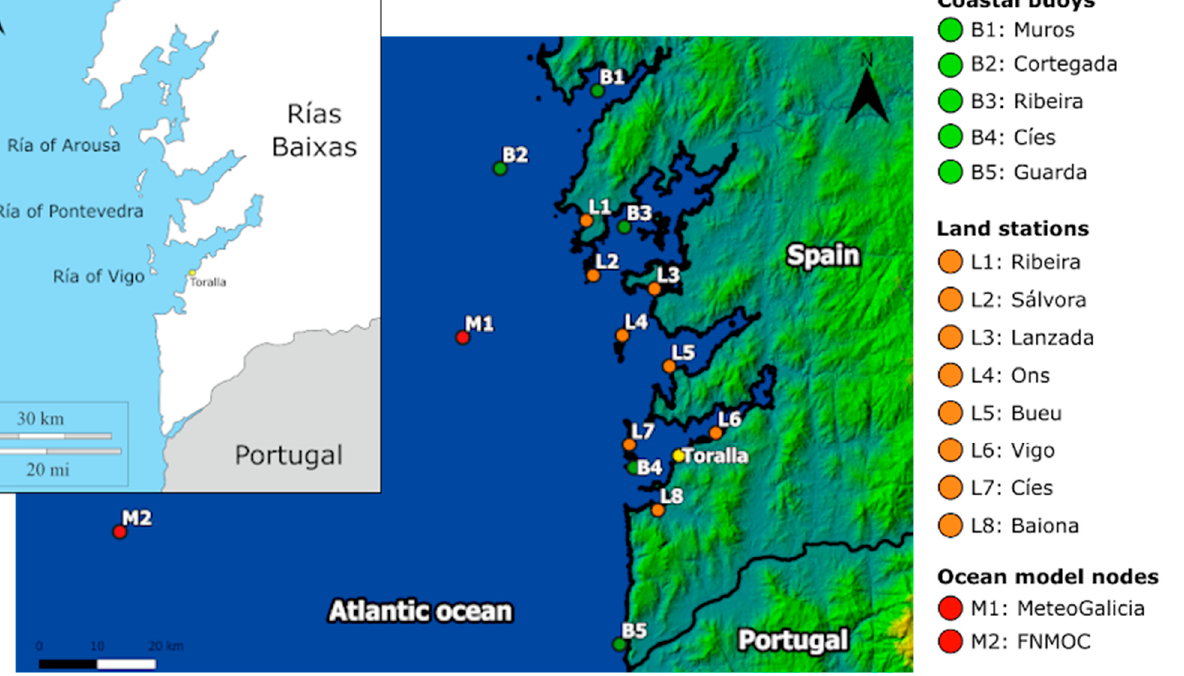
Figure 1. Map of the Rías Baixas shore, including the location of the different data sources.